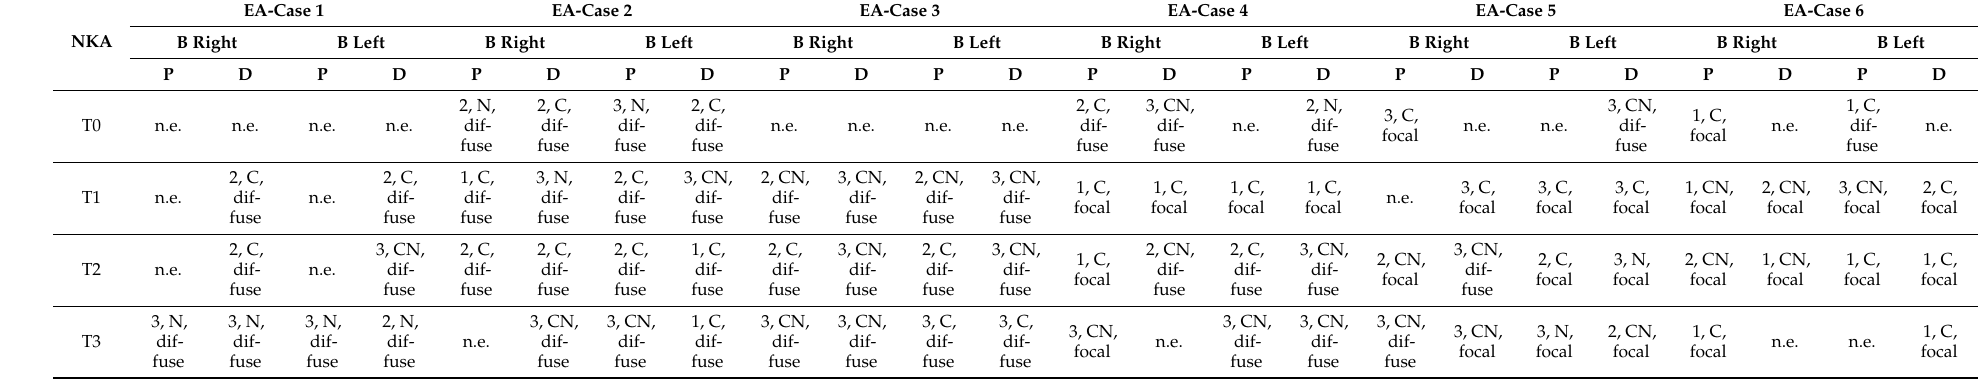
Table 4. Results of immunohistochemical evaluation to NKA of all endoscopic samples in the six EA-affected horses in all phases of experimental trial (T0, T1, T2, T3).